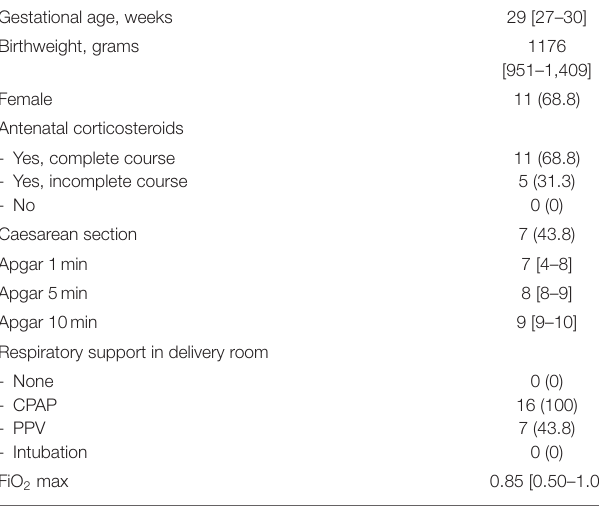
TABLE 3 | Respiratory and cardiovascular variables during the first 24h after birth, n =